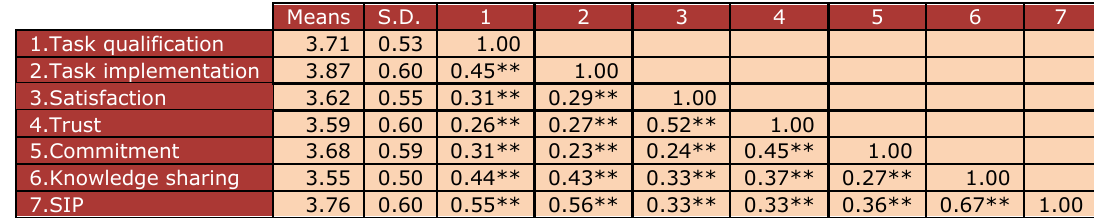
Table 2. Means, standard deviations, and